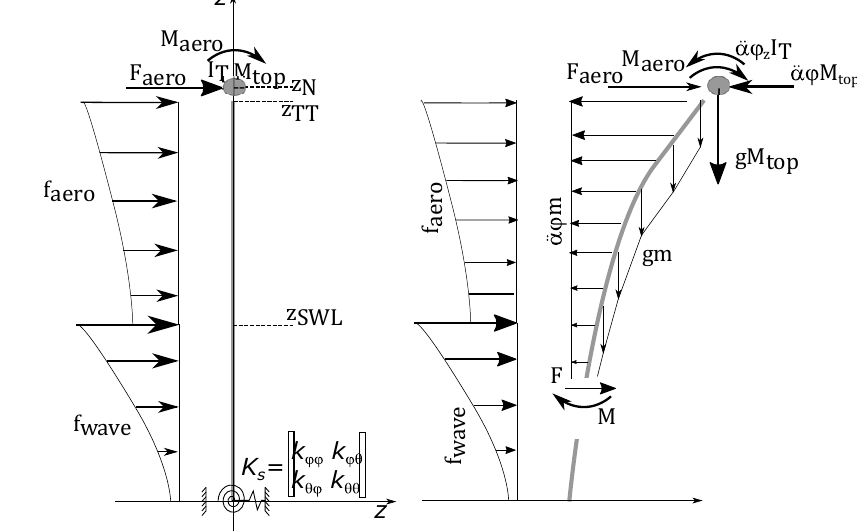
Figure 2. (a) Sketch of the beam and the external forces. (b) The external and internal forces that contribute to sectional force, F , and moment, M